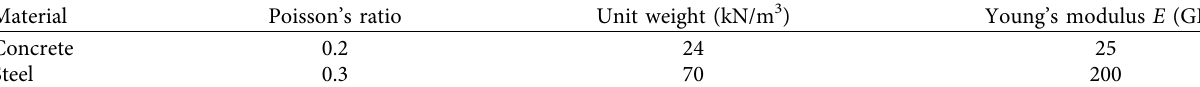
Table 1: Material parameters